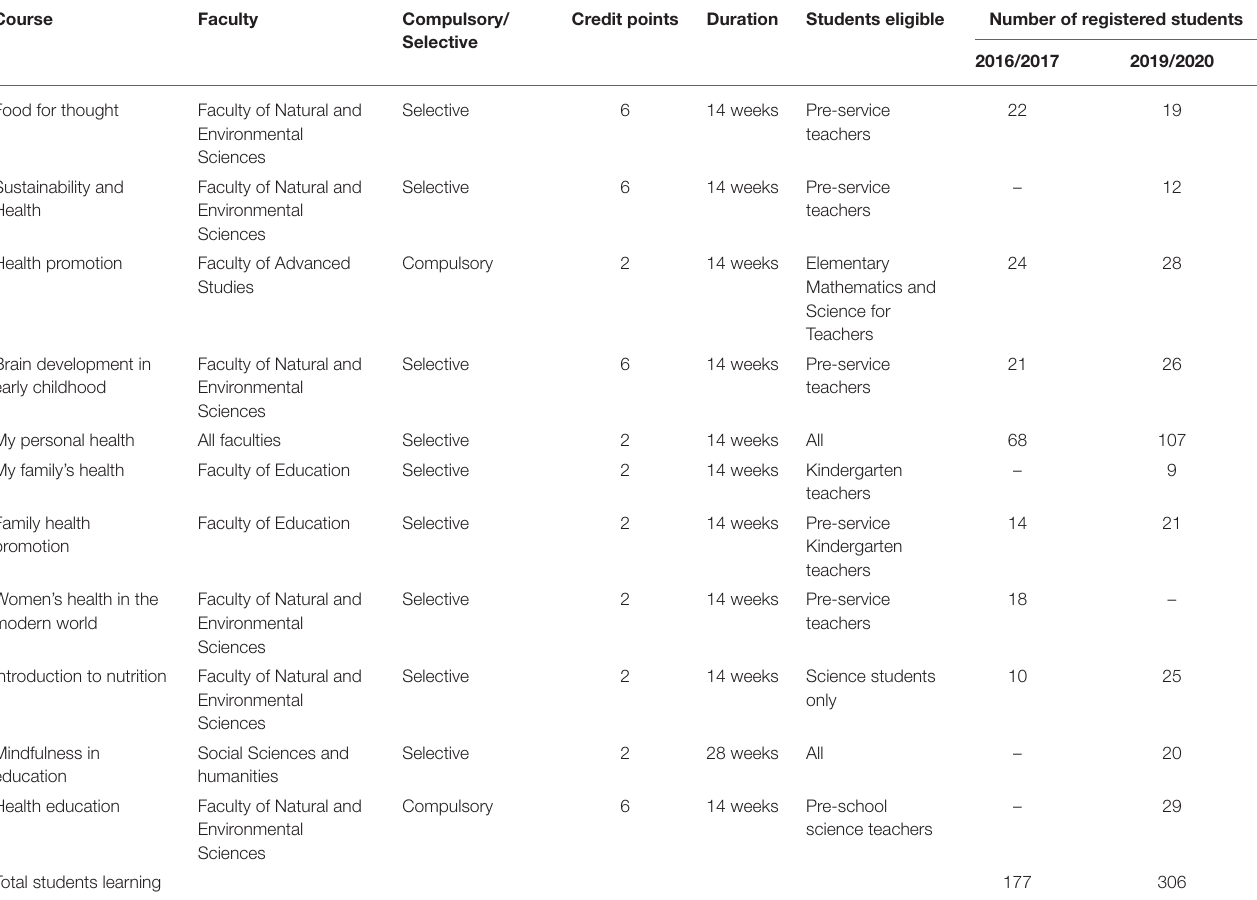
TABLE 4 | Courses related to health promotion (including new courses introduced in